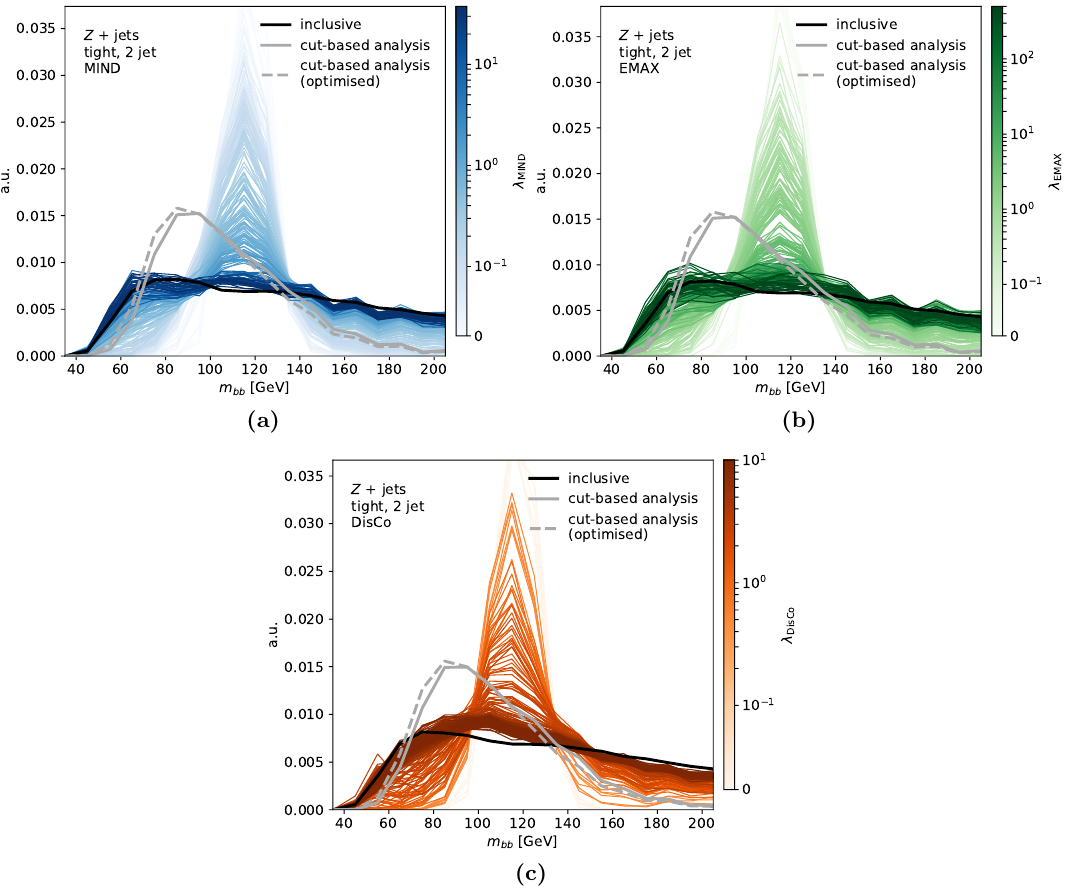
Figure 3 . Invariant mass distributions produced by Z +jets events in the two-jet tight DCA categories, for MIND in (a), EMAX in (b) and DisCo in (c). The shade of the lines corresponds to the value of (cid:21) used in the training. The thick black line shows the inclusive distribution, i.e. the one obtained for the corresponding jet multiplicity, but without any further selections applied. The grey lines correspond to the distributions obtained for the equivalent CBA high- E miss region. Distributions are shown both for the original (solid) and optimised (dashed) cut